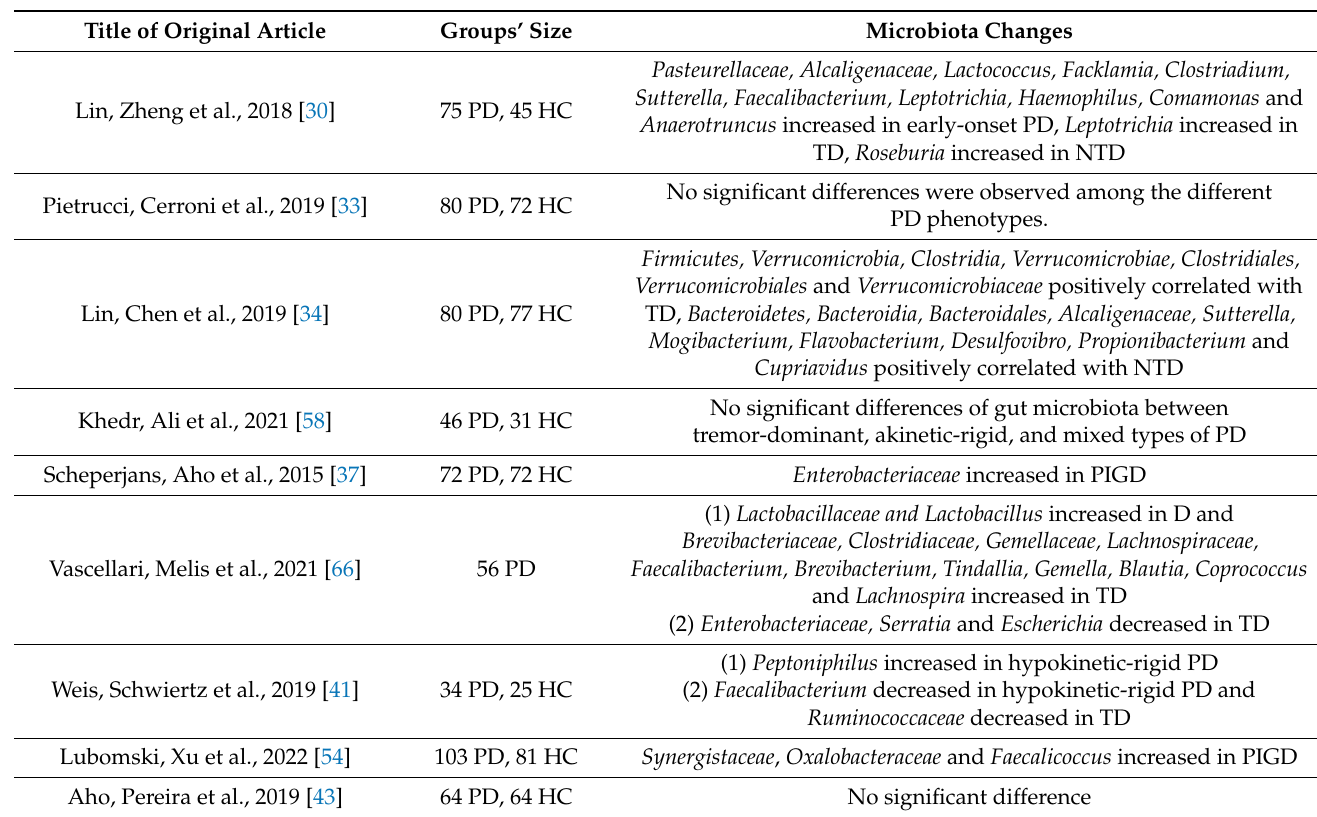
Table 4. Clinical phenotypes of Parkinson disease: research papers and their conclusions (TD— tremor-dominant phenotype of Parkinson’s disease, NTD—non-tremor dominant phenotypes of Parkinson’s disease, PD—patient with Parkinson’s disease, HC—healthy control, PIGD—Postural Instability and Gait